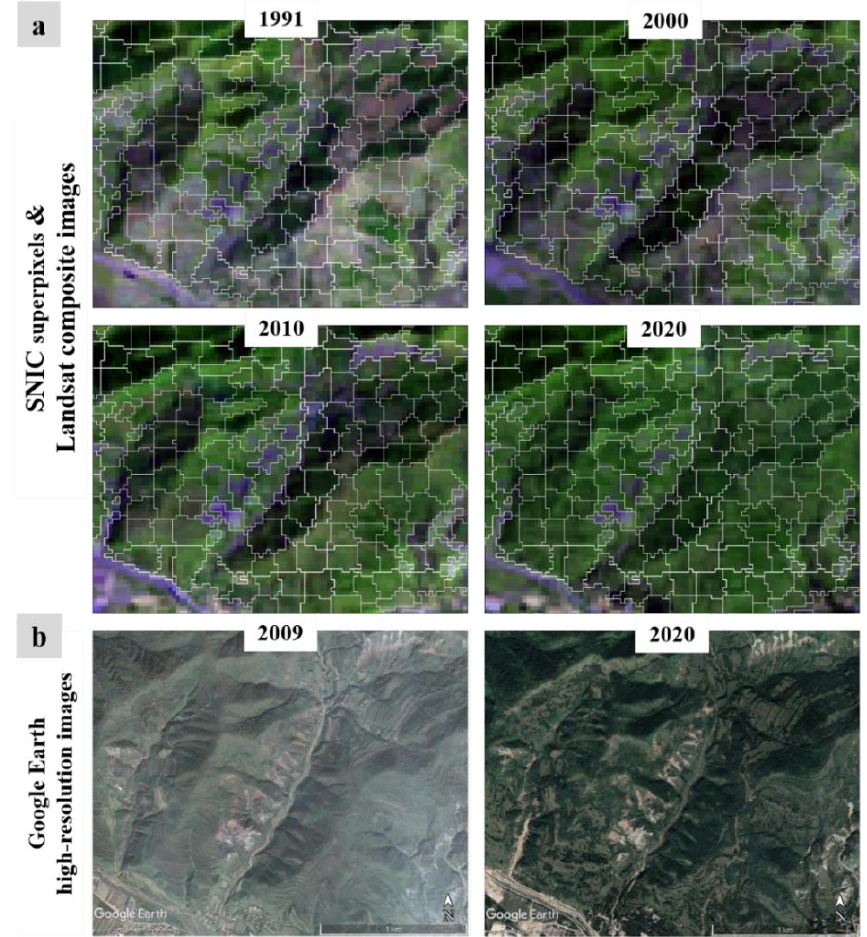
Figure 8. ( a ) SNIC superpixels (white polygons) against the background of Landsat composite images in 1991, 2000, 2010, and 2020. ( b ) High-resolution images on Google Earth in 2009 (the earliest) and 2020 as reference data.